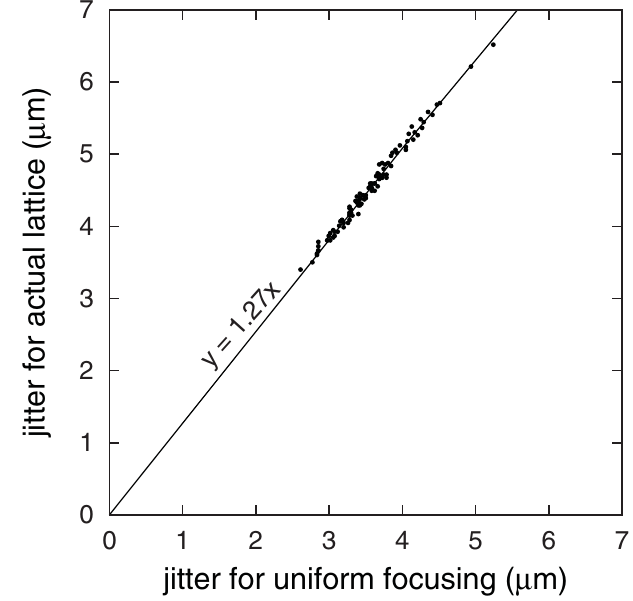
FIG. 5. Correlation between extraction jitter assuming uniform focusing, and for the actual lattice with local focusing, for 100 seeds of random injection